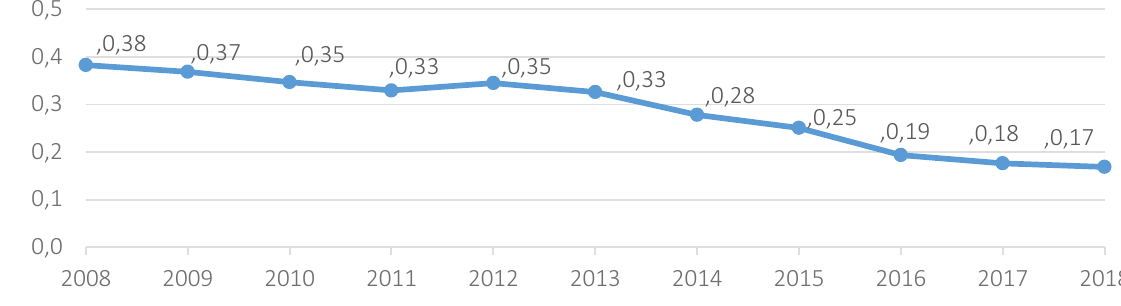
Figure 5. Internal current expenses for R&D in Odesa region in 2008–2018, percent to